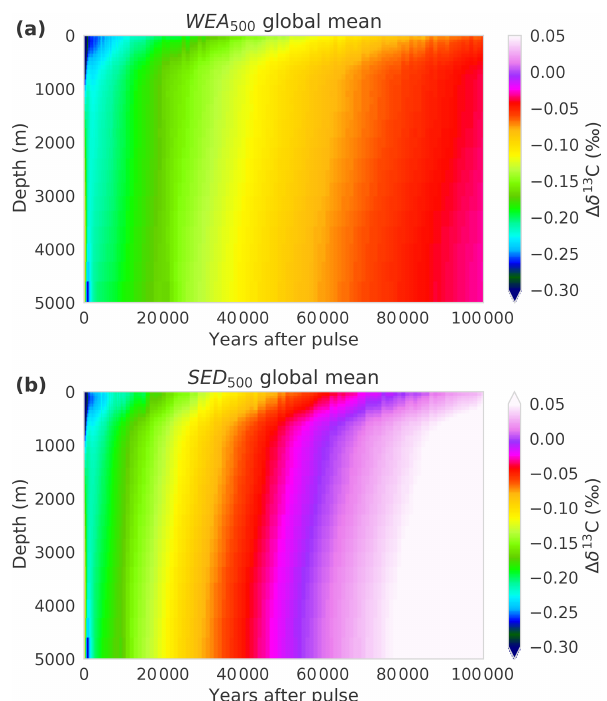
Figure A1. Hovmöller-type diagram showing the temporal evolu- tion of the global-mean vertical profile of (cid:49)δ 13 C DIC for experi- ments (a) WEA 500 and (b) SED 500